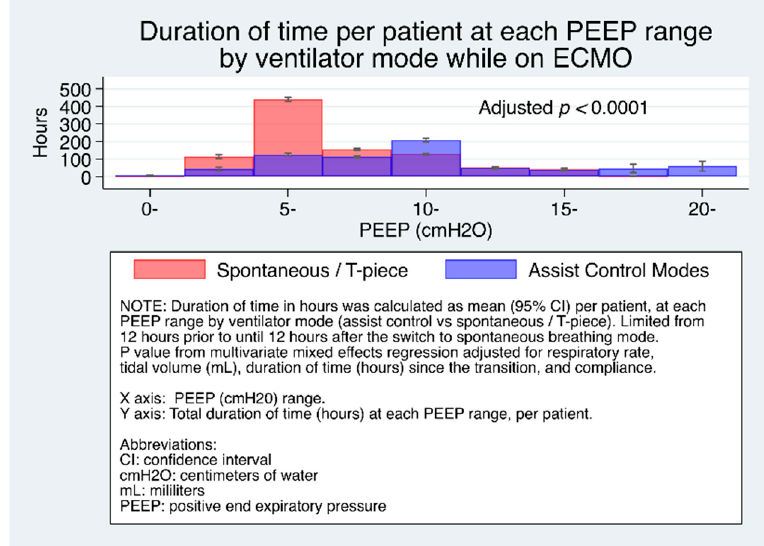
Figure 1. Duration of time (median, 95% CI) per patient at each PEEP range by ventilator mode.